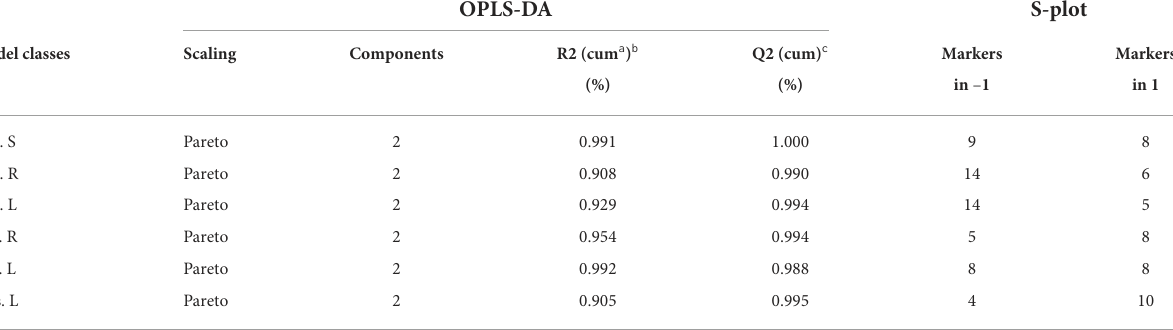
TABLE 1 Statistical parameter values of different orthogonal partial least-squares discriminant analysis (OPLS-DA) models based on ultra-performance liquid chromatography coupled with quadrupole/time-of-flight mass spectrometry (UPLC-Q-TOF-MS/MS) data in positive mode and the number of markers selected from